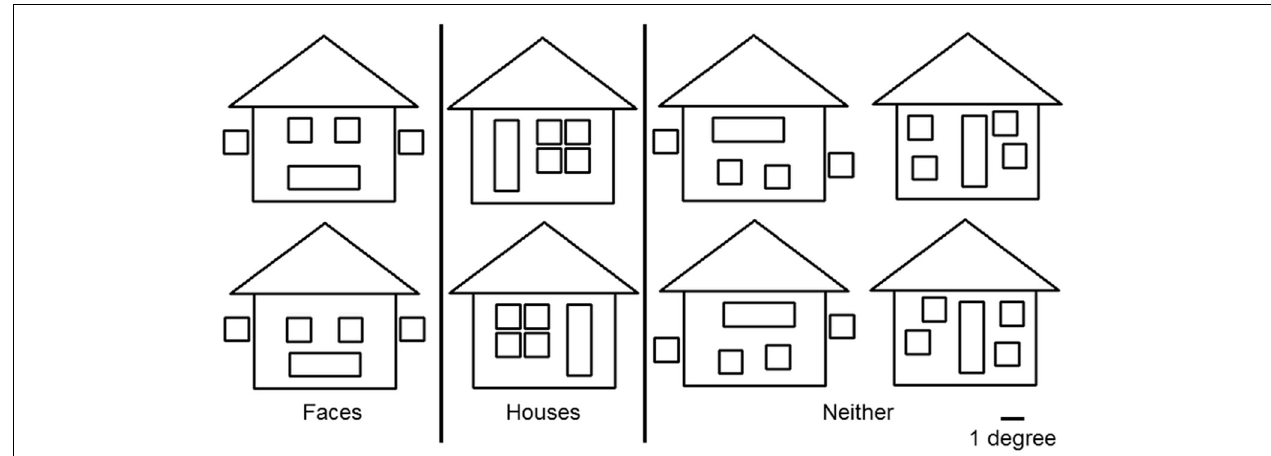
FIGURE 2 | Three categories of stimuli. “ Face ” and “ House ” stimuli were composed of the same lines but had configurations that made them easily recognizable as belonging to one category or the other. The “ Neither ” category consisted of four figures that were not easy to categorize as “ Face ”